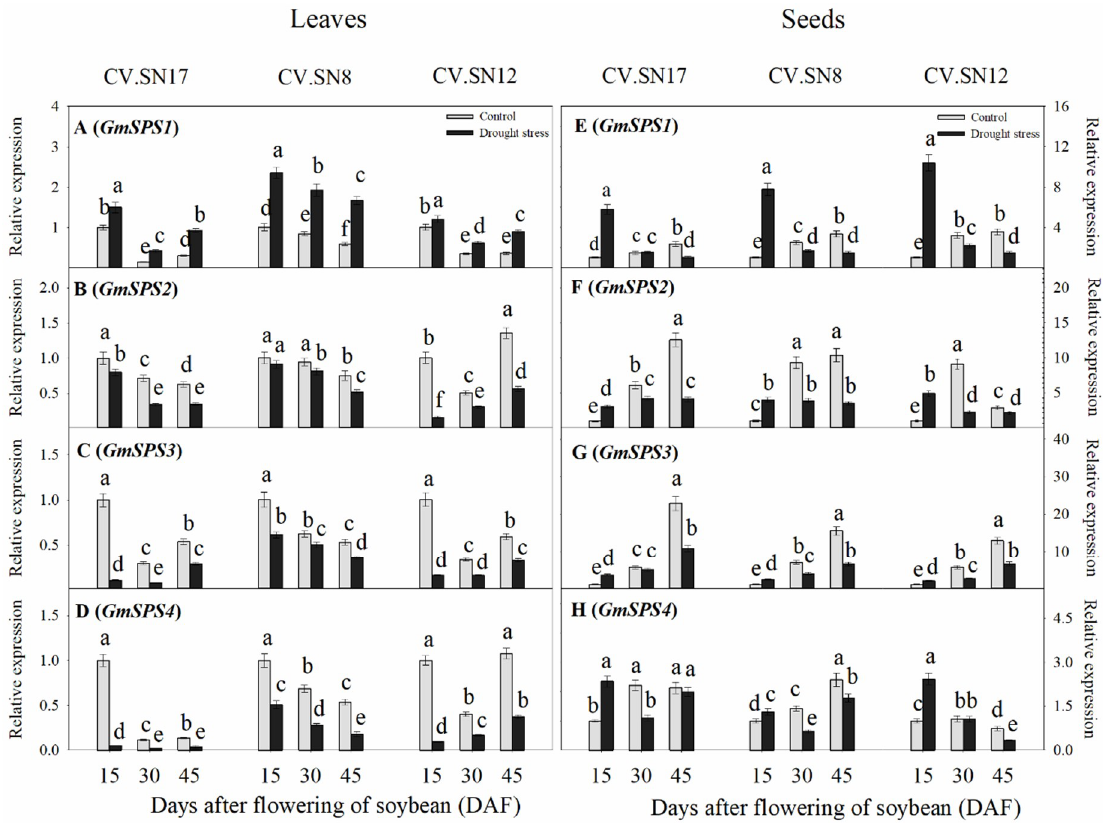
Figure 5. Effect of drought stress on the expression levels of GmSPS genes in leaves and seeds: ( A , E ) GmSPS 1; ( B , F ) GmSPS2 ; ( C , G ) GmSPS3 ; and ( D , H ) GmSPS4 . Standard deviations were calculated